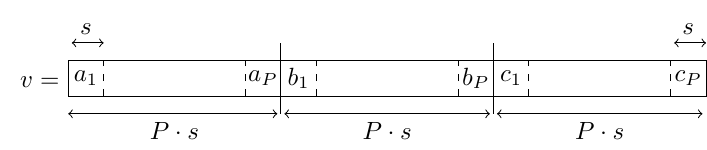
Figure 2: Representation of an index v of the table